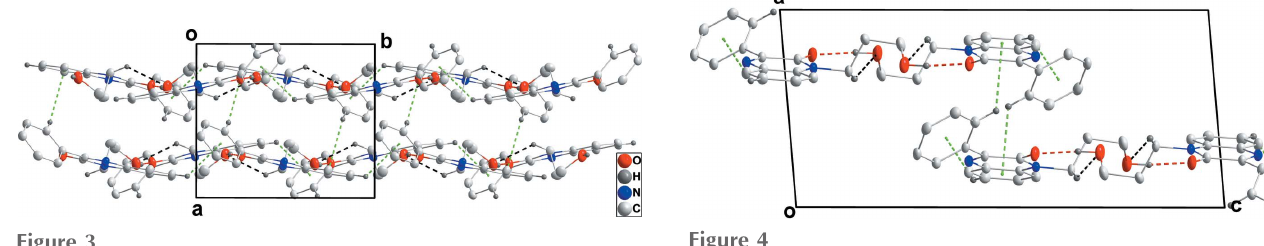
Figure 2 Part of the crystal structure viewed along the a -axis direction. The O— H (cid:2)(cid:2)(cid:2) O and C—H (cid:2)(cid:2)(cid:2) O hydrogen bonds are shown, respectively, by red and black dashed lines. C—H (cid:2)(cid:2)(cid:2) (cid:2) (ring) interactions are shown by green dashed lines.